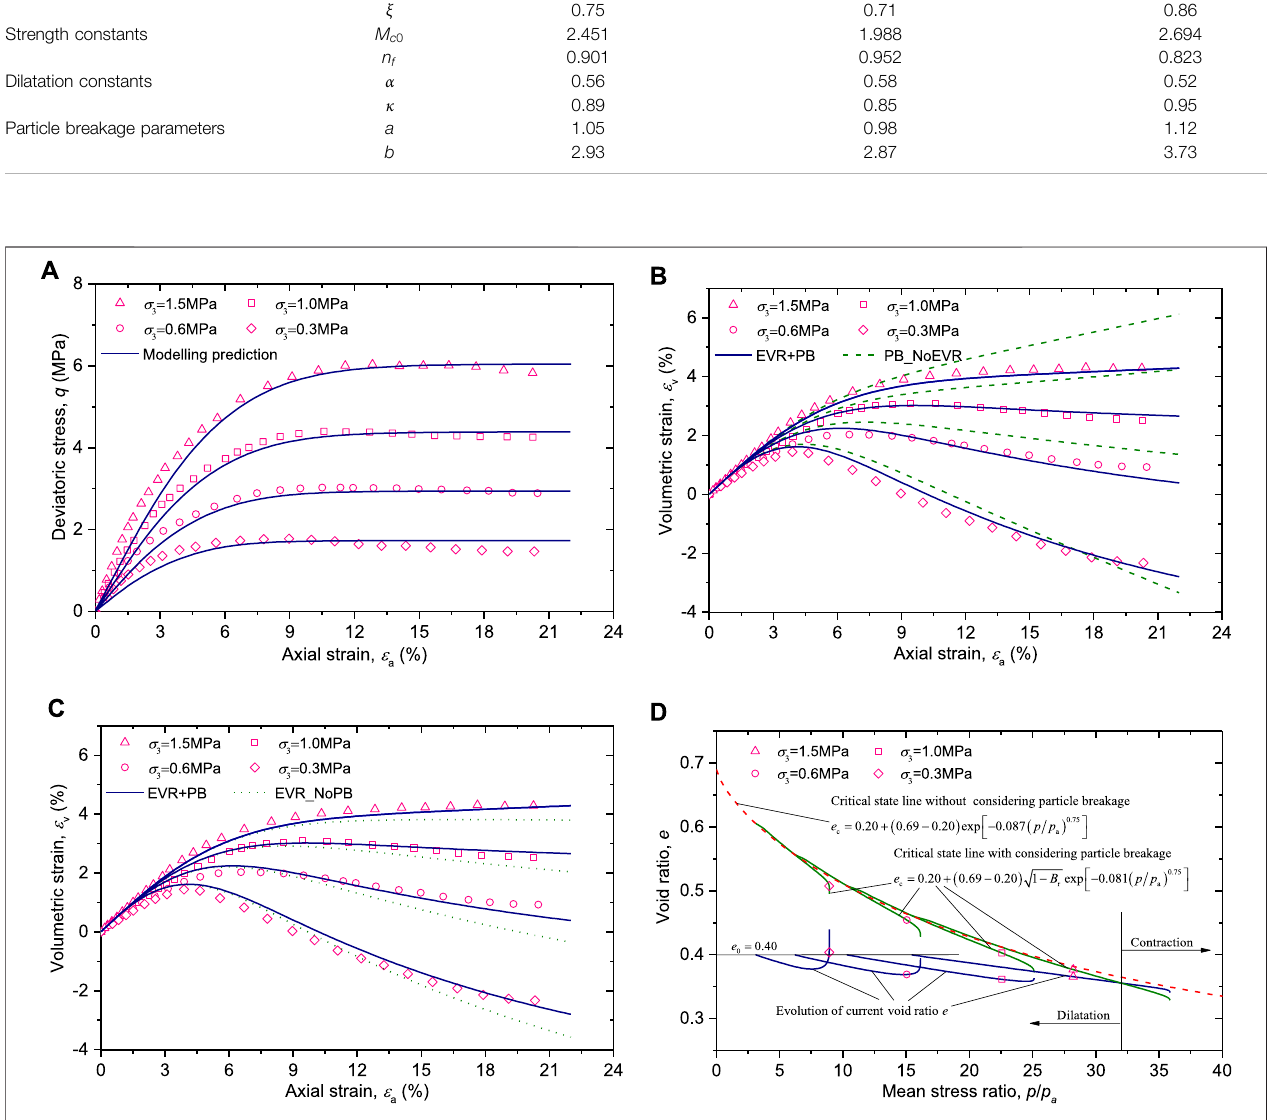
Frontiers in Physics |